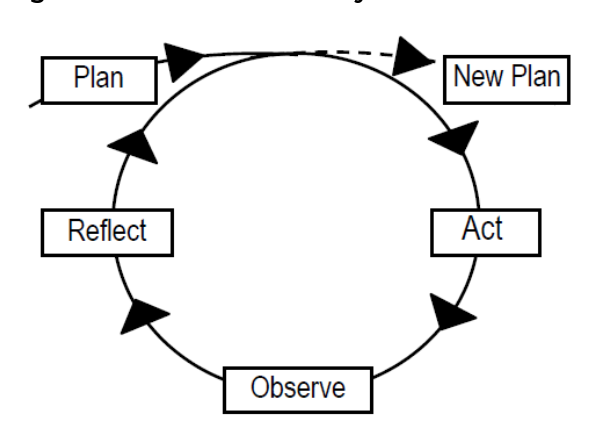
Figure 1: Action Research Cycle